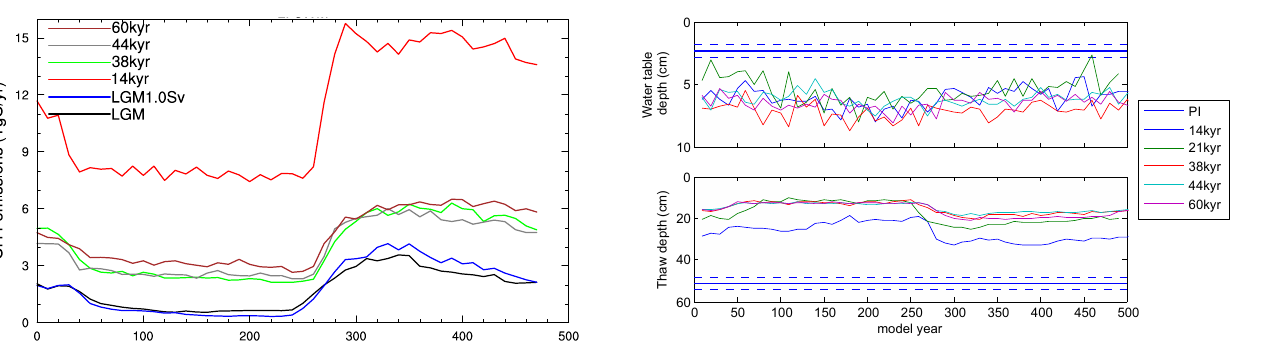
Fig. 7. Decadally averaged (northwards of 45 ◦ N) water table depth and thaw depth in the LPJ-WHyMe simulations. The pre-industrial simulated mean ± 2 standard deviations (dashed lines) are shown for